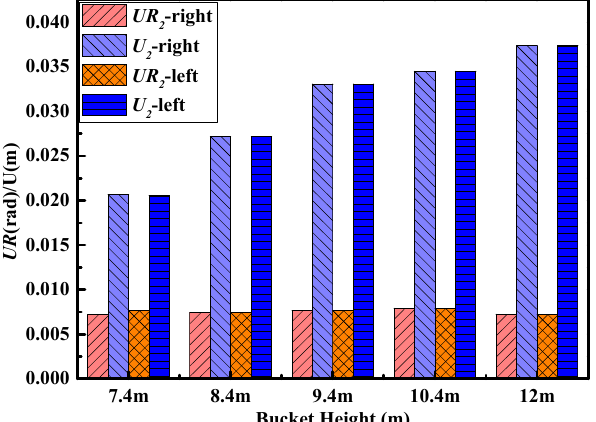
Figure 11. Average rotation angle and horizontal displacement of the bucket foundation under different bucket skirt heights.